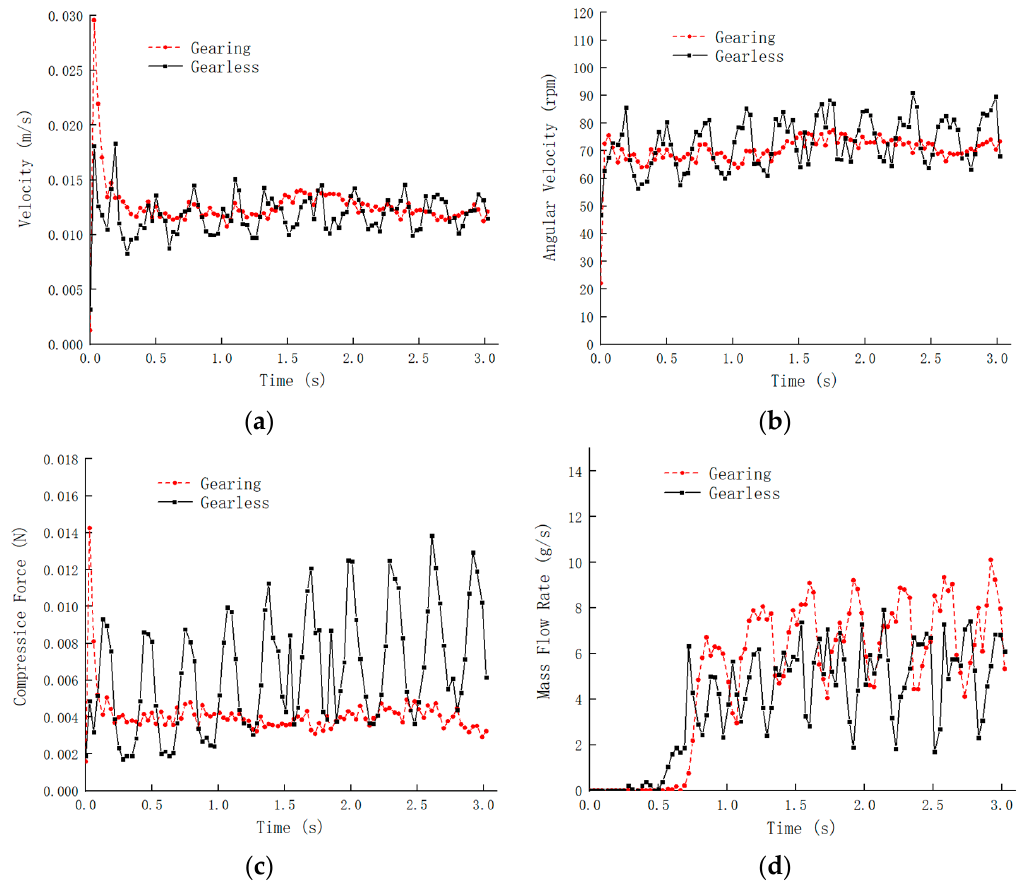
Figure 9. Comparative analysis of seed movement characteristics: ( a ) variation of population linear velocity with time, ( b ) variation of population angular velocity with time, ( c ) variation of the compressive force on the population with time, and ( d ) variation of the seed mass flow rate with time. Table 2. Seed motion characteristic